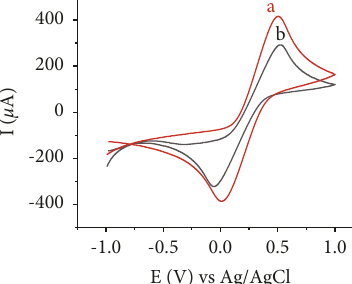
Figure 5: CVs of K 3 [Fe(CN) 6 ] at unmodified CPE (a) and HDPBA ‒ CPE (b); scan rate: 0.1V/s.